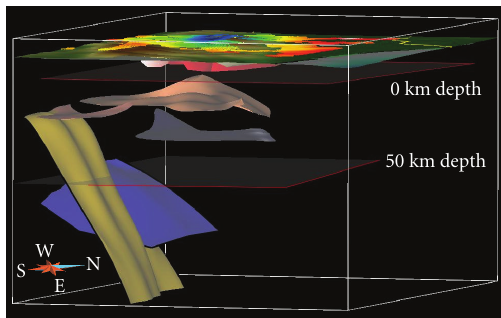
Figure 15: A perspective view of the geophysical interfaces compiled from seismic and gravity modeling from east. On top, the Bouguer gravity field is displayed, shifted up 20 km together with bodies from L¨ucke’s local density model. Below, the down-dipping plate and other interlithospheric interfaces of the Central American crust-mantle system from 3D tomography and receiver function analysis are shown. They were displayed for joint interpretation at our Geowall